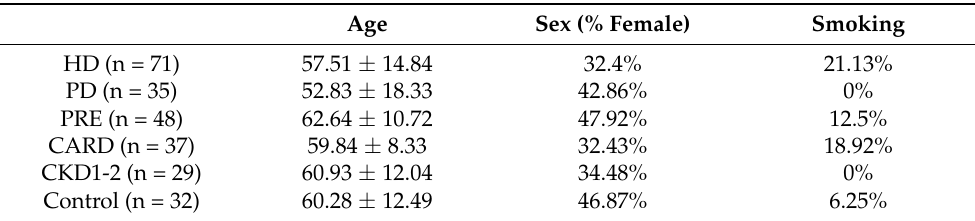
Table 1. Basic information about age (mean ± standard deviation), sex (percent of females), and tobacco usage (percent of smokers) within the groups.